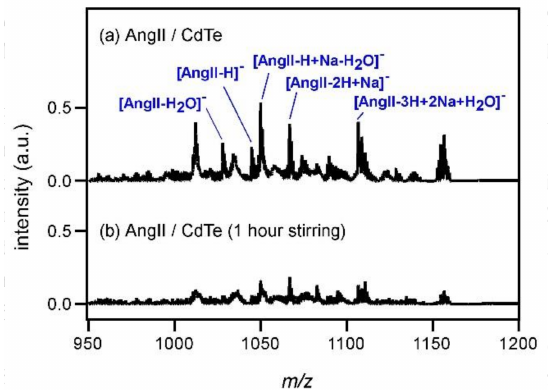
Figure 4. Mass spectra of angiotensin II (AngII) measured ( a ) with CdTe and ( b ) with CdTe after stirring for 1